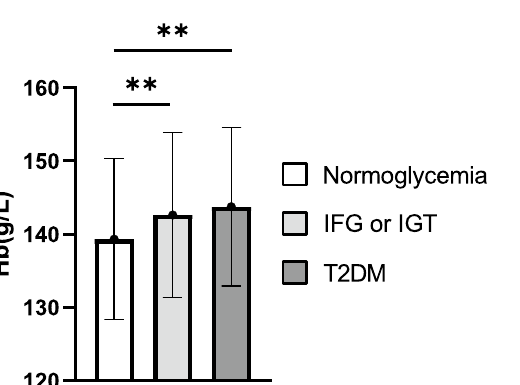
Figure 3. Prevalence of glucose intolerance/diabetes according to baseline Hb levels in previously normoglycemic subjects at the follow-up. Baseline mean ± SD Hb levels of 437 normoglycemic subjects shown in respect to glucose tolerance status at the follow-up. Normal glucose tolerance (normoglycemia), impaired fasting glucose (IFG) or impaired glucose tolerance (IGT) and type 2 diabetes (T2DM) were determined according to the World Health Organization (WHO) criteria. Alcohol consumption, smoking, BMI, sex and age were included as covariates. Hb